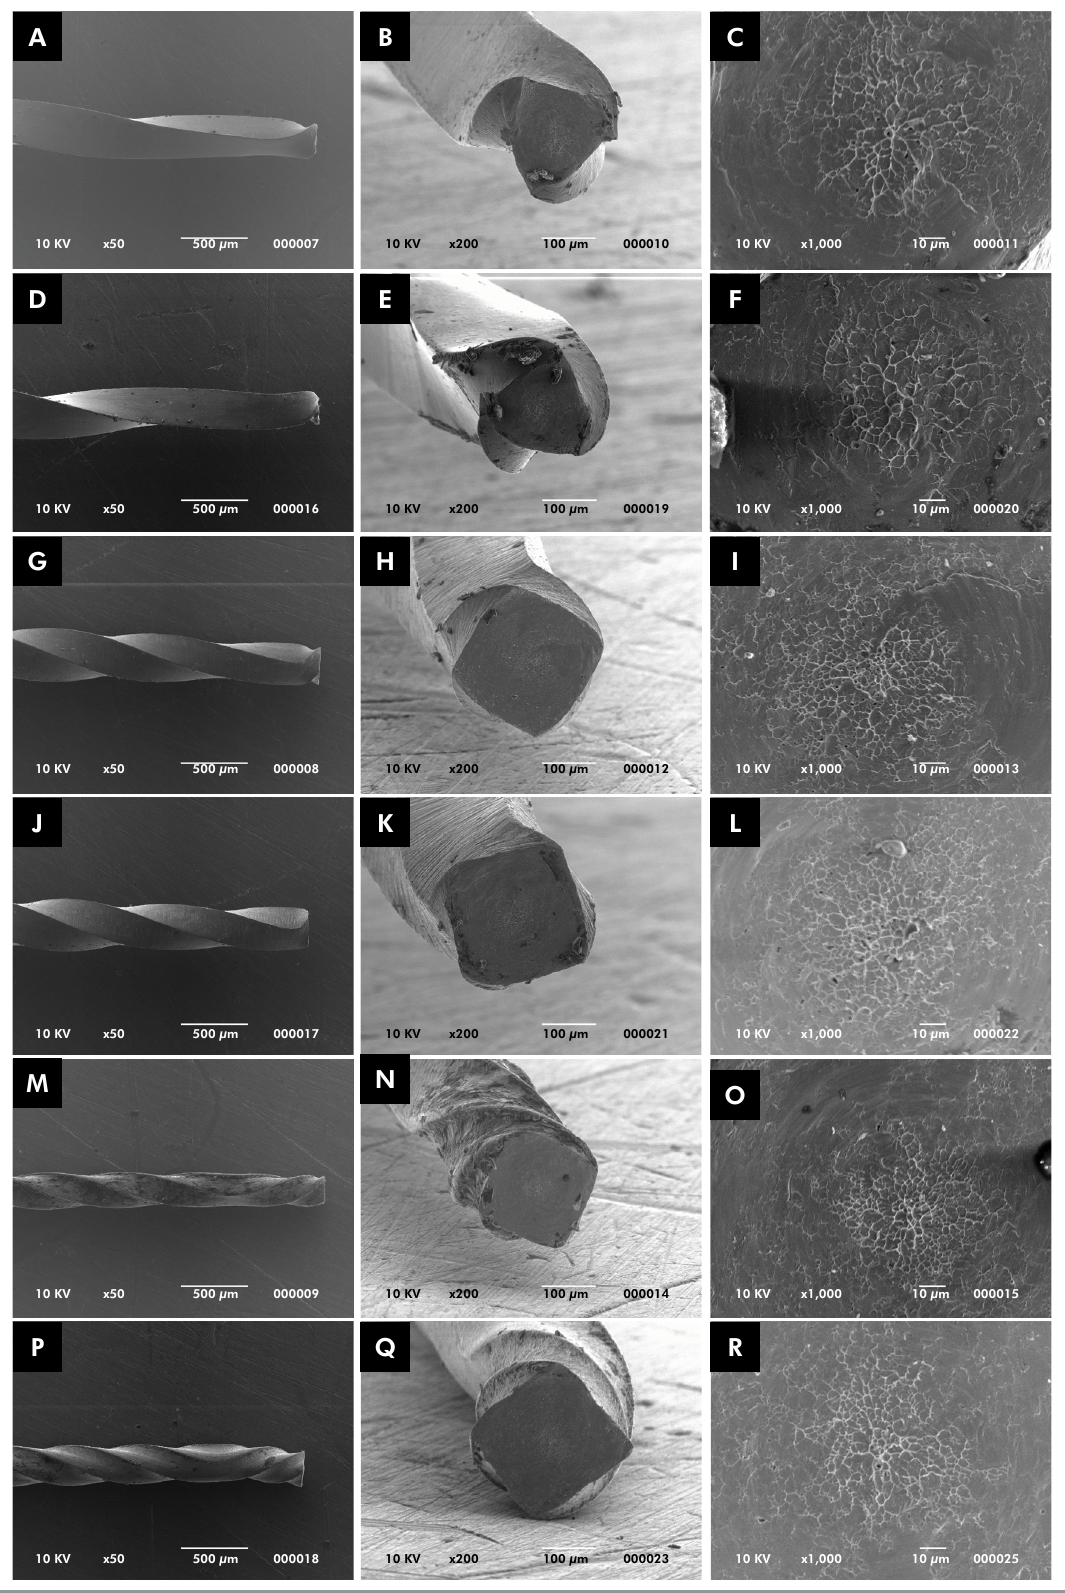
Figure 3. Scanning electron microscopy images of new (A, B, and C; G, H, and I; M, N, and O) and used (D, E, and F; J, K, and L; P, Q, and R) instruments of BT-Race, Sequence Rotary File, and ProDesign Logic systems, respectively, after torsional fatigue